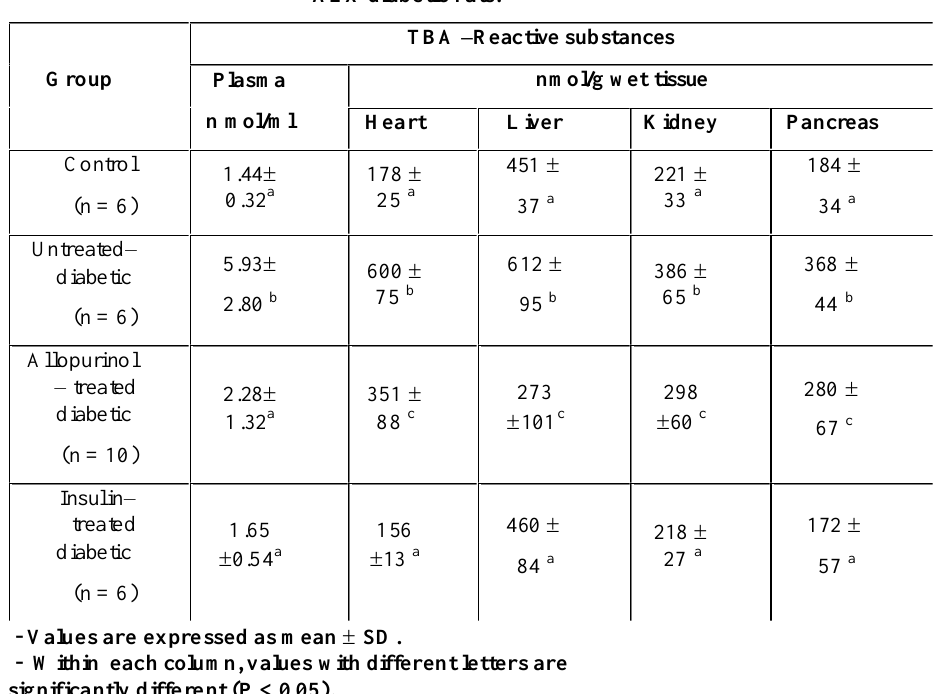
Table 3: Plasma and tissue TBA – reactive substances (an index of lipid peroxidation) in control, untreated – ALX diabetic, allopurinol – treated – ALX diabetic, and insulin treated – ALX diabetic